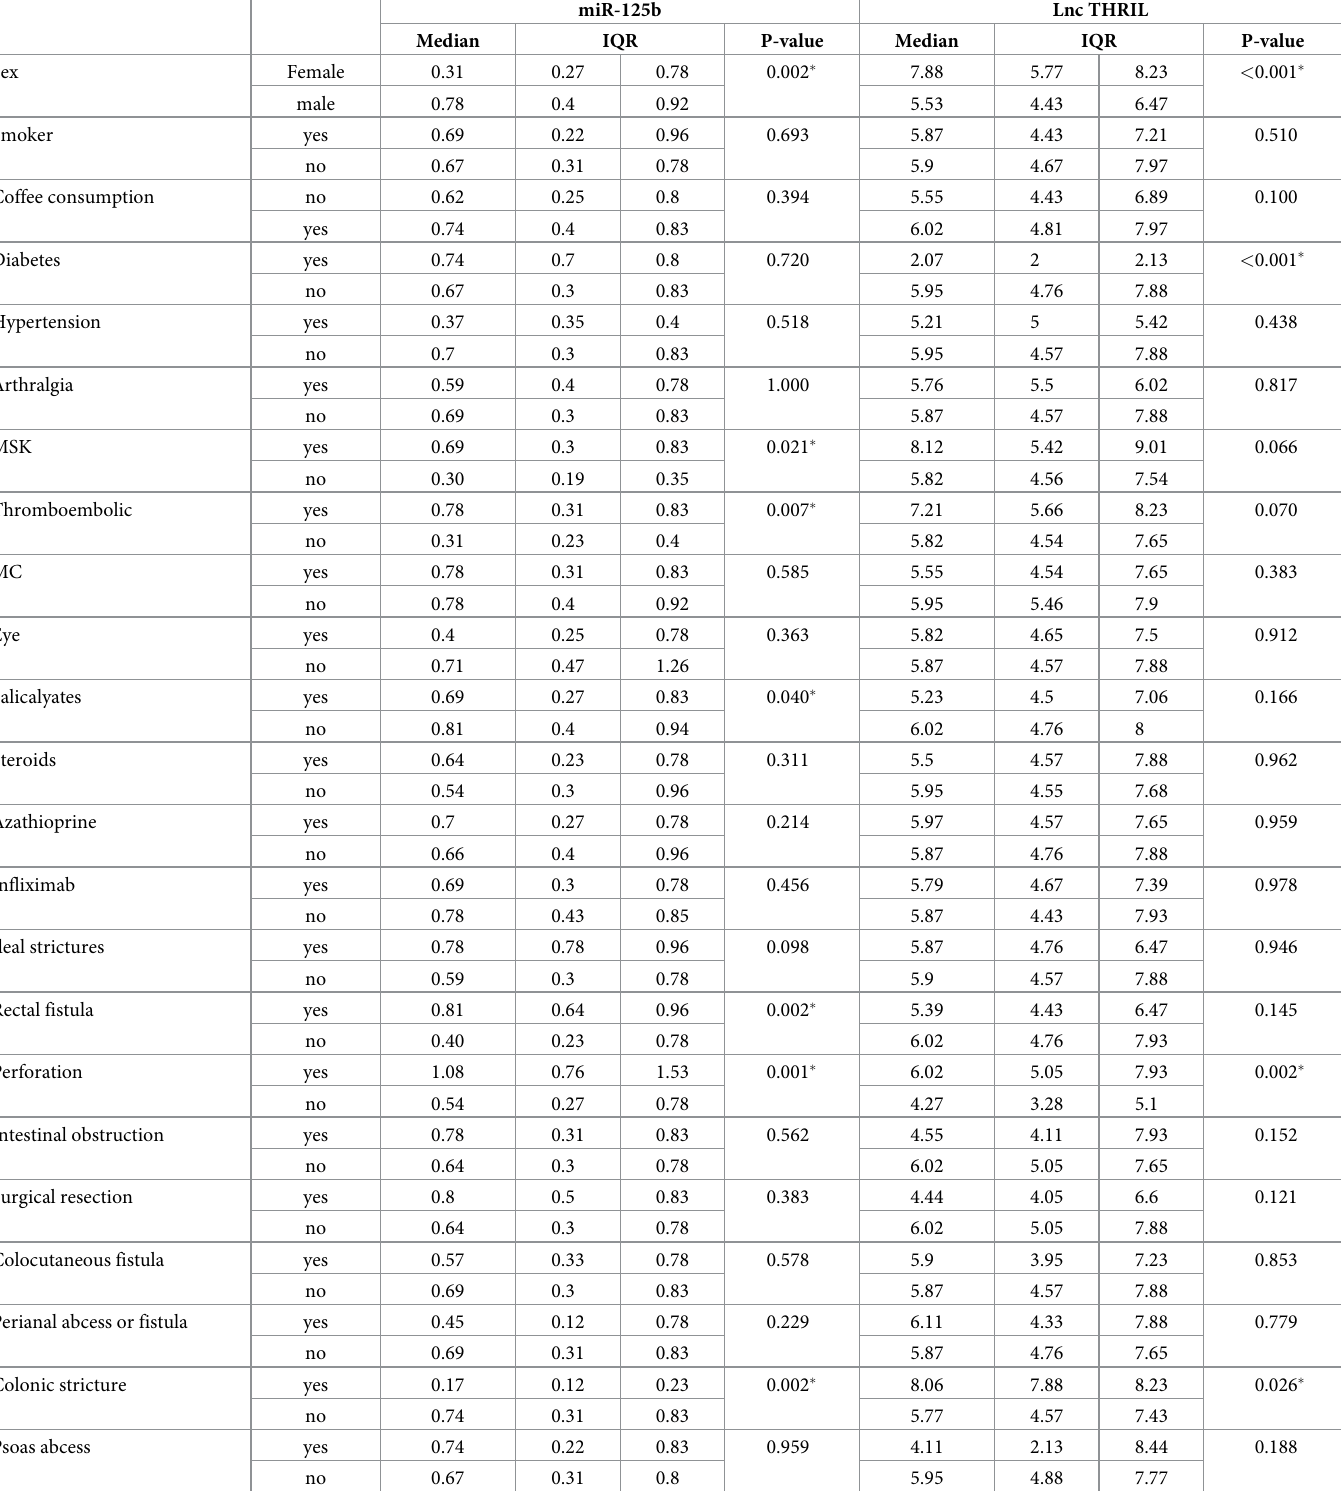
Table 4. Relations between Lnc THRIL and MiR-125b and clinical data in CD